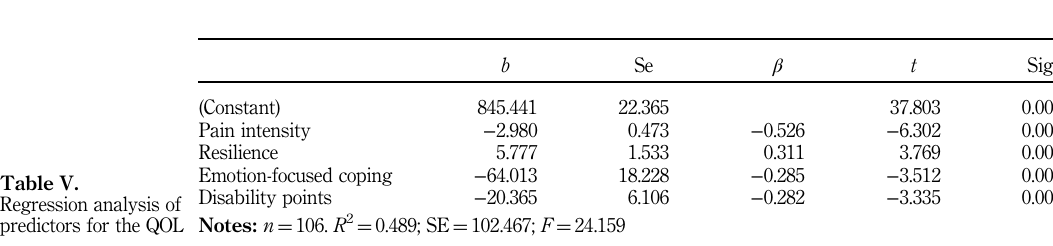
Table IV. Descriptive data of four predictors